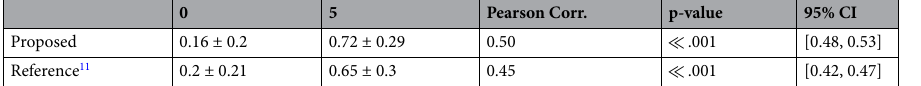
Table 5. Summary of the results of the proposed and reference approach in test2. The first two columns show the average ± standard deviation fQRS scores assigned to signals labelled as 0 and 5. The third and forth columns show the correlation coefficients between the fQRS scores and the ground truth labels from 0 to 5, both with p-values below .001.